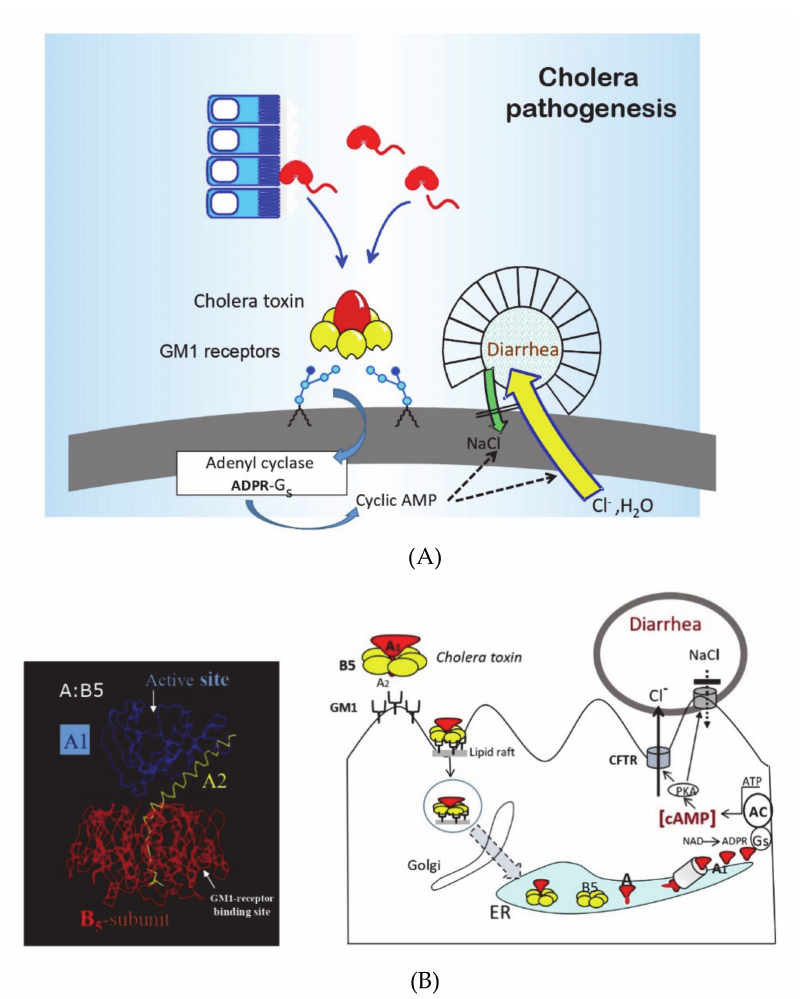
Figure 1. Pathogenesis of cholera and mode of action of the cholera toxin. ( A ) In the 1970s, the pathogenesis of cholera rapidly became better understood than any other infectious disease, as summarized in this figure from a Nobel Symposium on cholera in 1978 (A-M. Svennerholm, p.162 in [4]). After ingesting contaminated food or water, V. cholerae bacteria colonize the small intestine and secrete the cholera toxin, a doughnut-like protein with a central enzymatic toxic-active A (A 1 + A 2 ) subunit that is associated with a cell-binding pentamer of B subunits (B5). After binding to cell surface receptors identified as the GM1 ganglioside (the first-ever structurally defined mammalian cell receptors), the A subunit dissociates from the B subunits and its A1 entity binds to and ADP- ribosylates the GTP-binding Gs adenyl cyclase protein. This leads to the production of cyclic AMP (cAMP), which in turn induces the secretion of chloride, bicarbonate, and water from intestinal crypt cells and blocks sodium chloride and water uptake from villus cells, resulting in the watery